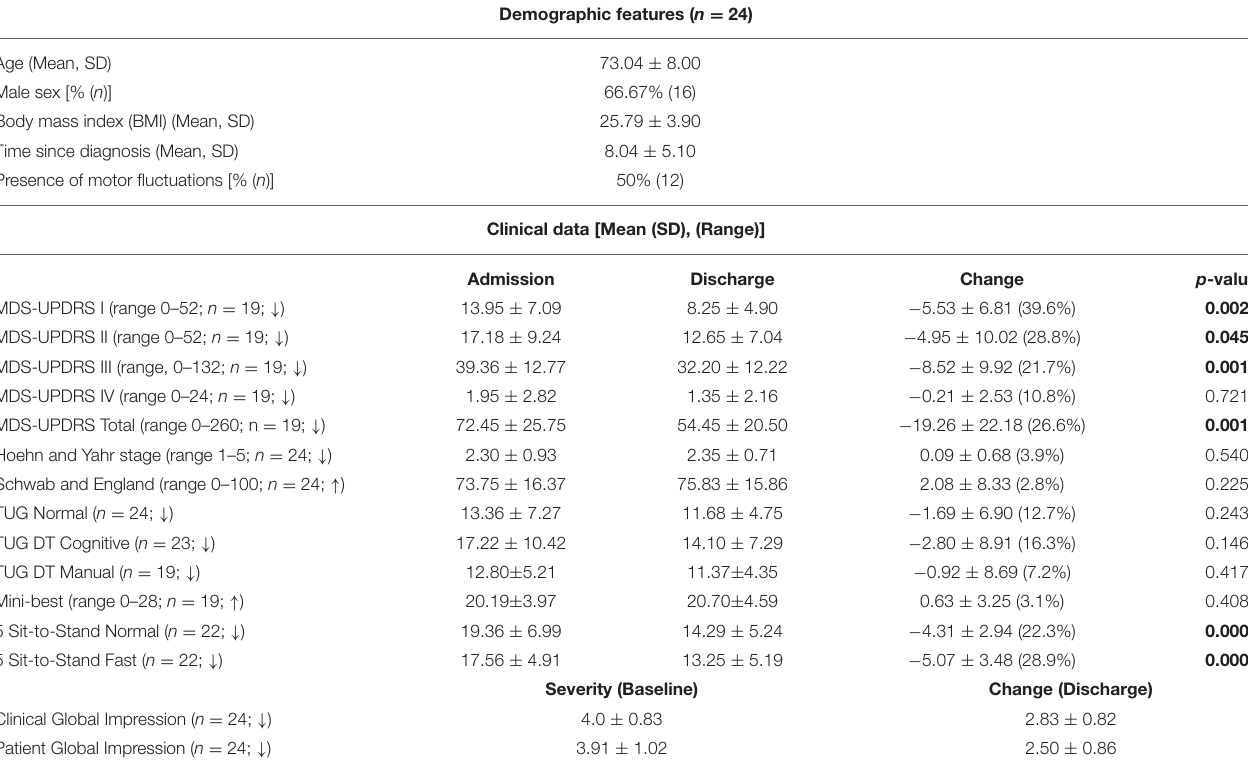
TABLE 1 | Demographical and clinical characteristics of the